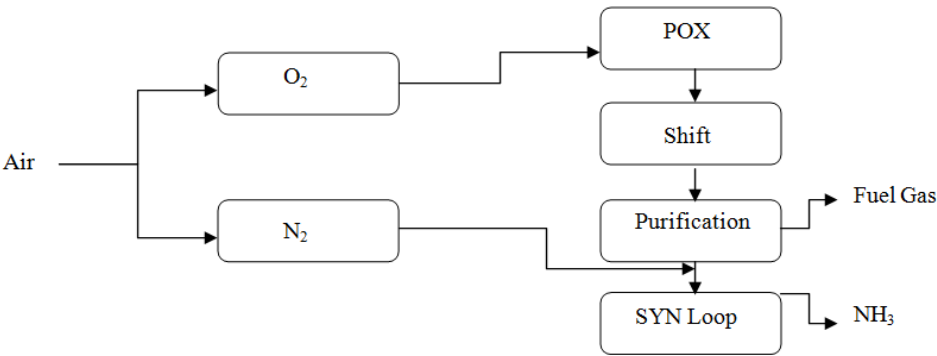
Figure 3. Ammonia process flowsheet for Casale A-60 concept, reproduced from the reference [21].